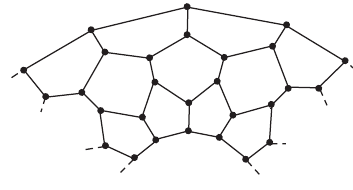
Figure 7: Te graph of R